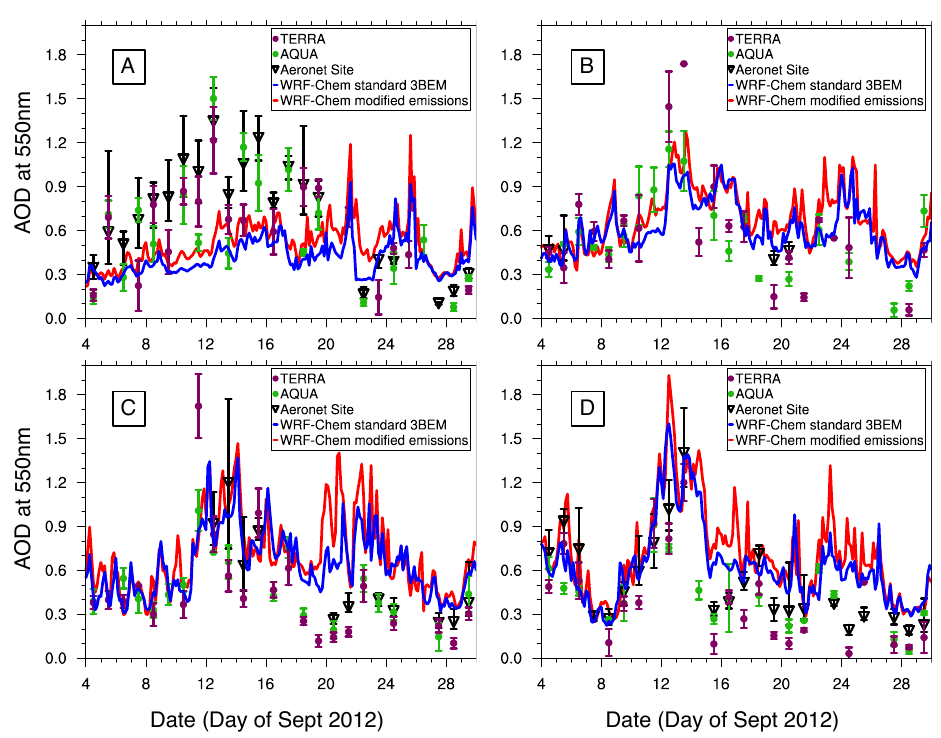
Figure 6. Time series of aerosol optical depth at 550nm at four AERONET sites between 4 September and 1 October 2012: (a) at Cuiabá; (b) at Ji Paraná; (c) at Porto Velho; and (d) at Rio Branco. Blue triangles show AERONET site daily measurements, with bars indicating range in values over the day. Purple and green circles indicate measurements from overpasses of TERRA and AQUA satellites respectively, with bars indicating error range. Blue lines show data from WRF-Chem model simulations using standard 3BEM emissions. Red lines show data from WRF-Chem model using the modified